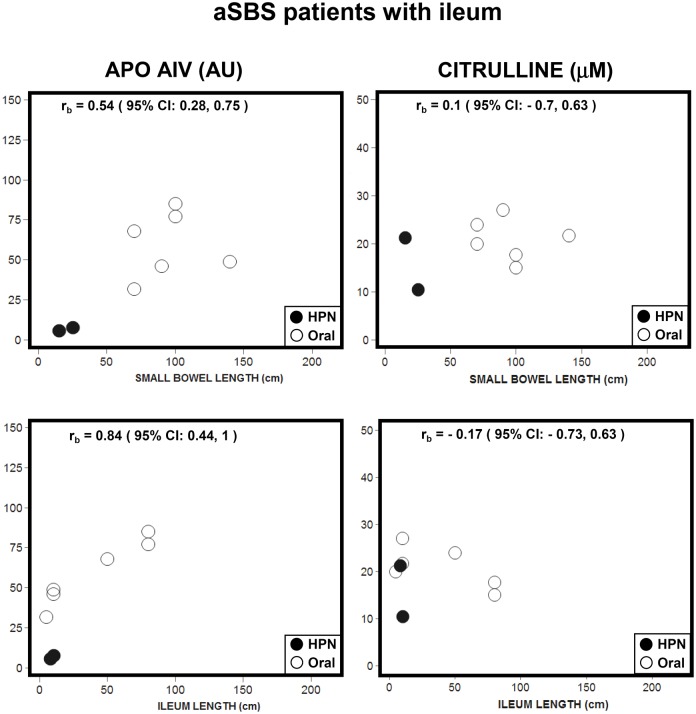
Scatter plots for Apo AIV and citrulline plasma values with the RSBL and a remnant ileum length in adapted SBS patients with ileum and proximal part.(●) HPN group (n = 2) and (o) ORAL group (n = 6). Bootstrap resampling correlation was performed.